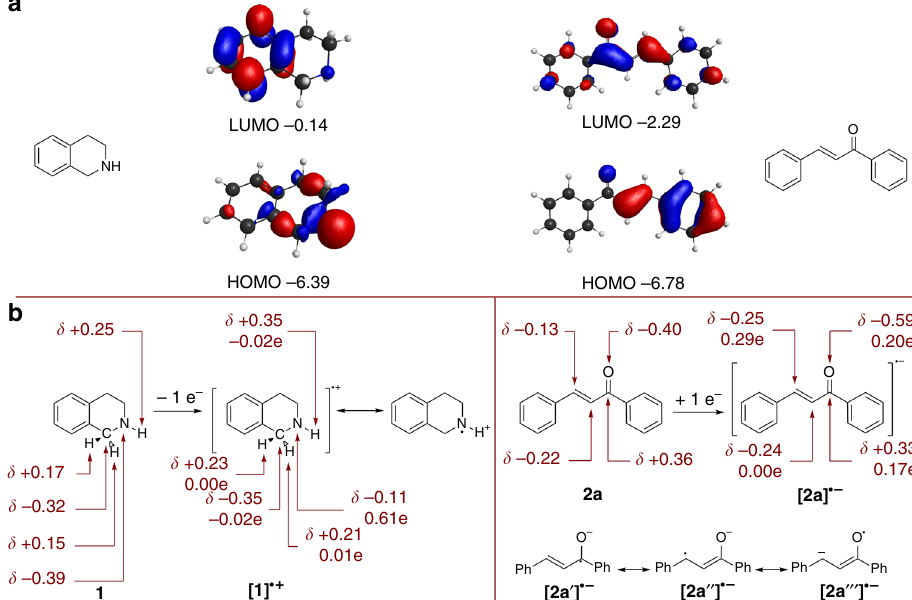
Fig. 8 The results of DFT PBE0-D3 calculations. a Absolute energies of the frontier molecular orbitals (in eV vs. vacuum level) of THIQ 1a and chalcone 2a and their spatial representation. b Distribution of atomic charges ( δ ) in neutral molecules, THIQ radical cation [ 1a ] ∙ + and chalcone radical anion [ 2a ] ∙ − . Mulliken spin population (in fraction of elementary charge) in THIQ radical cation [ 1a ] ∙ + and chalcone 2a radical anion [ 2a ] ∙ −